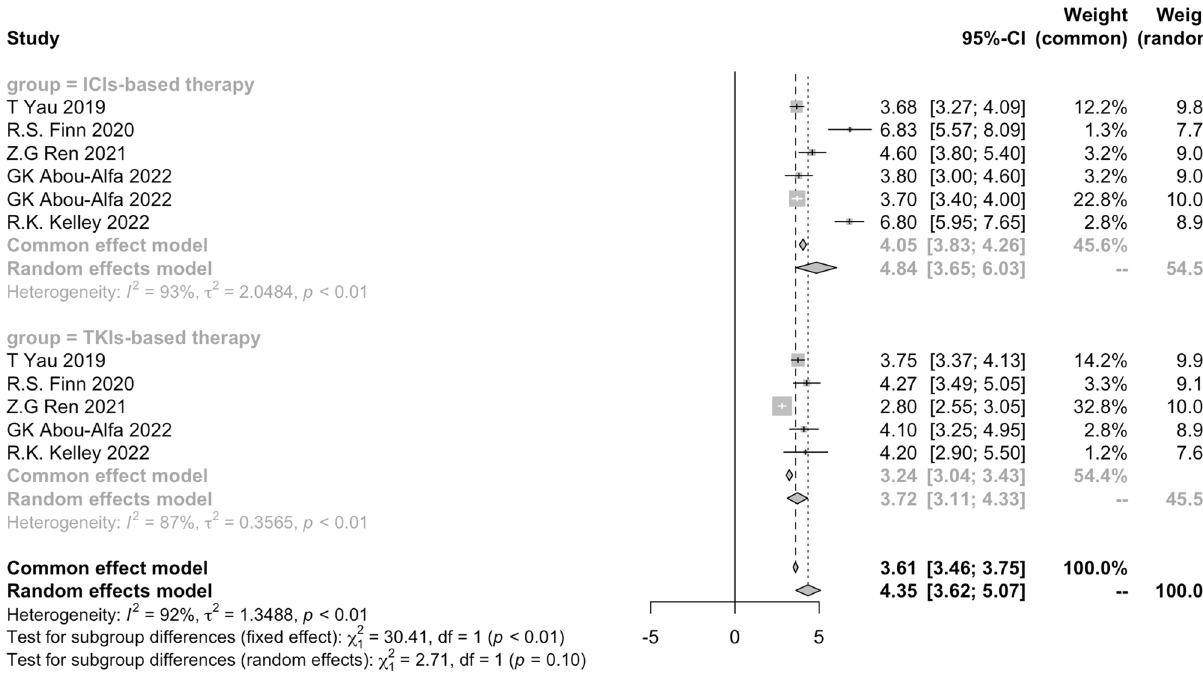
Fig. 4 Pooled results of PFS of ICIs vs TKIs